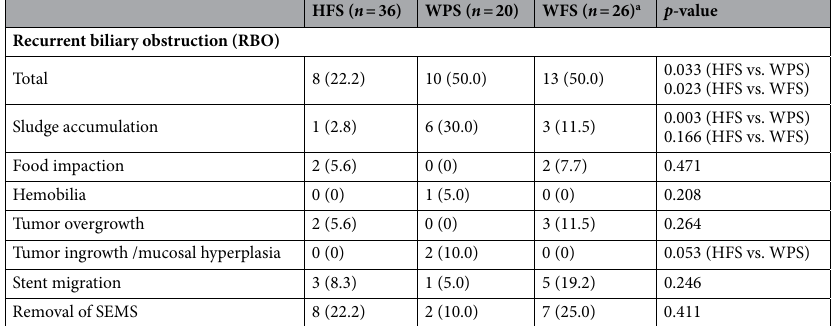
Table 2. The incidences of recurrent biliary obstruction and its causes. Data are presented as median (range) or number (proportion). SEMS Self-expandable metal stent, HFS HILZO fully covered stent, WPS WALLFLEX biliary RX partially covered stent, WFS WALLFLEX biliary RX fully covered stent. a Two patients in which SEMS was removed due to complications other than RBO were